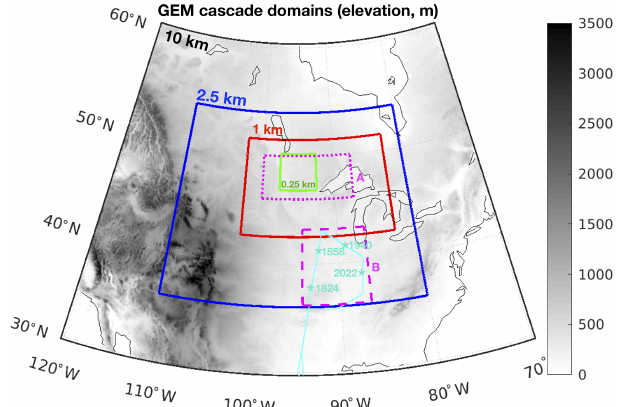
Figure 1. GEM cascade domains. Thick solid lines in black, blue, red and green represent simulation domains at 10, 2.5, 1 and 0.25km horizontal grid spacing, respectively. The thin cyan line represents the ER-2 aircraft flight path on 27 August 2013. The dot- ted magenta line represents evaluation Domain A, which covers the major convective events of this study. The dashed magenta line rep- resents Domain B for comparison between aircraft observations and model simulations. The four cyan stars show the locations and times (UTC) of the lowest location of the descending–ascending trajecto- ries of the